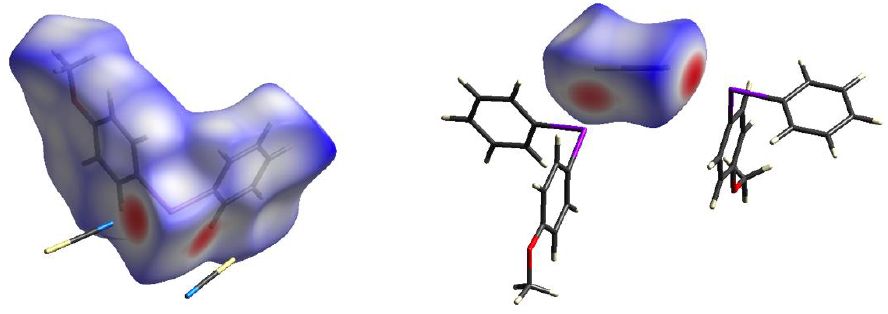
Figure 4. Hirshfeld surfaces for the [PhI(4-C 6 H 4 OMe)] + (left) and SCN − (right) ions. Table 2. Main partial contributions of di ff erent intermolecular contacts to the Hirshfeld surfaces for the [PhI(4-C 6 H 4 OMe)] + and SCN − ions.